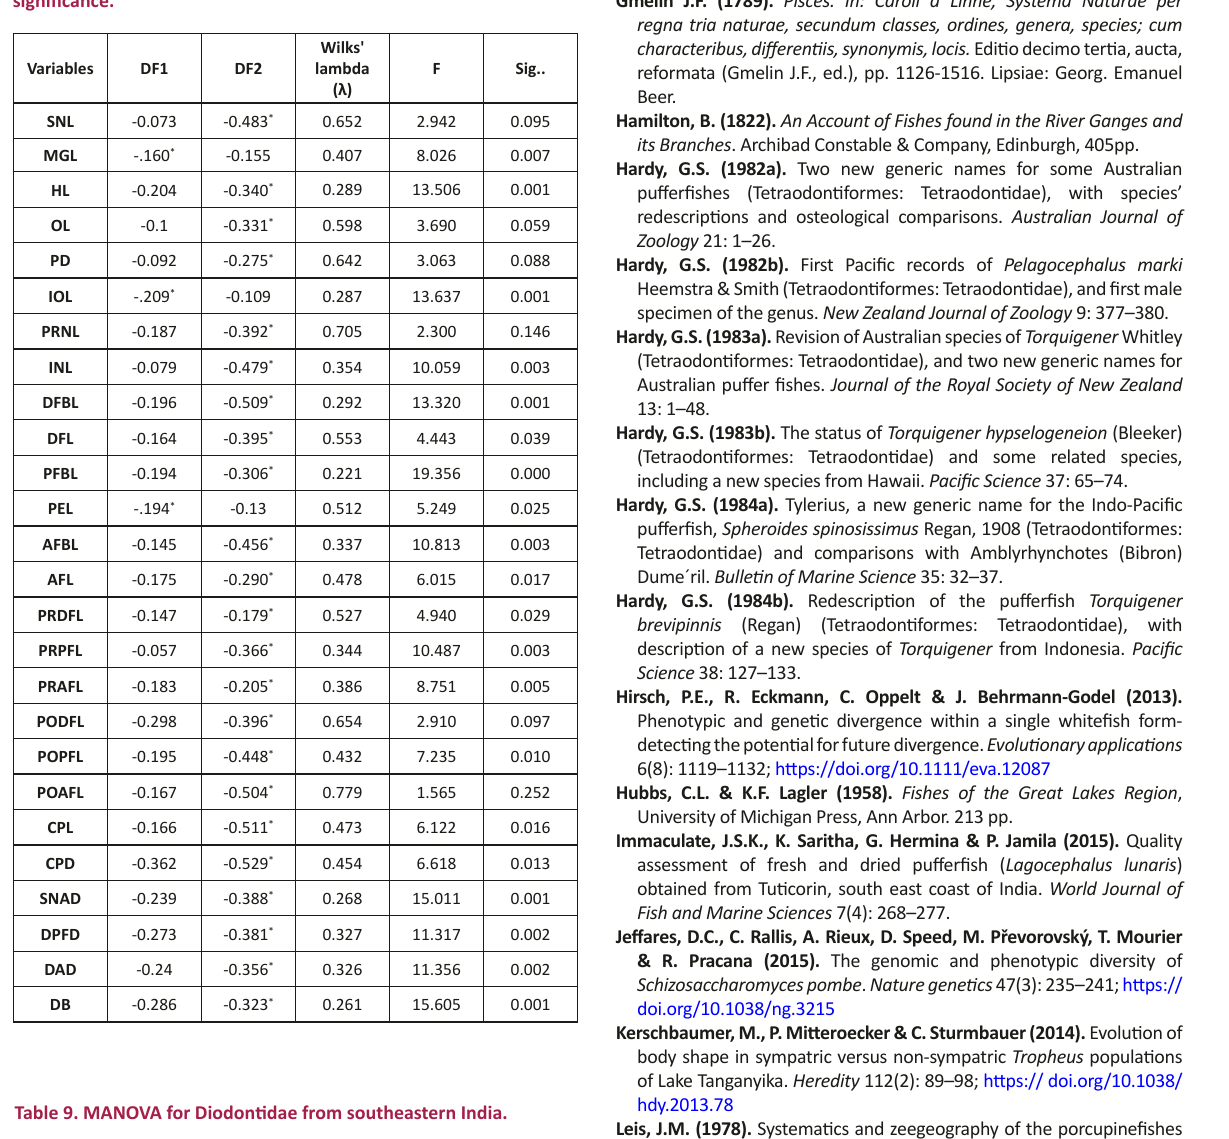
Table 8. Discriminant function analysis for Diodontidae — loading scores on the discriminant functions DF1 & DF2 and discriminatory power of morphometric characters Wilks’ lambda (λ), F value & significance.